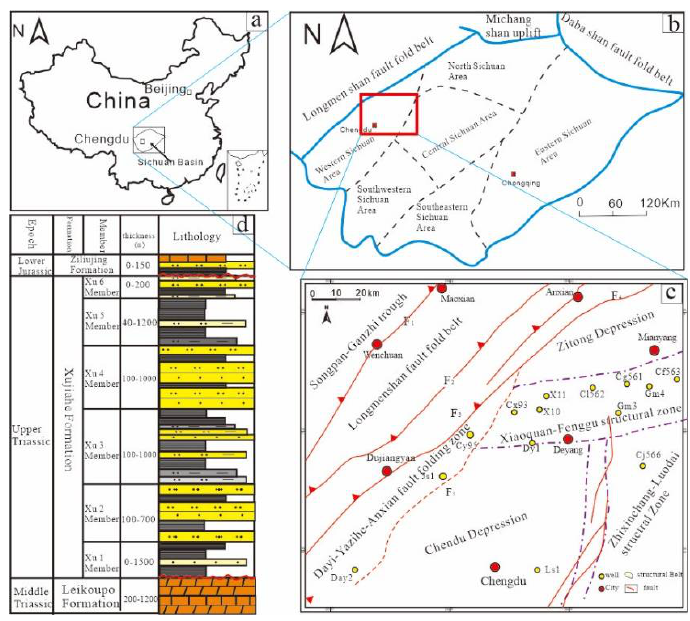
Figure 1. ( a ) The location of the Sichuan Basin; ( b ) Geological setting of the Sichuan Basin; ( c ) The tectonic divisions of the western Sichuan Basin; ( d ) Generalized stratigraphy and lithological types of the western Sichuan Basin.